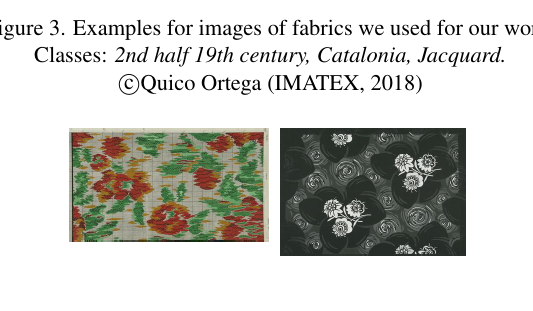
Figure 4. Examples for images of paper drawings we used for our work. Classes: Unkown production time and place, Drawing. c (cid:13) Quico Ortega (IMATEX, 2018) Table 1. Overview of the class distributions for all tasks. TS: production timespan . PL: production place . TE: technique